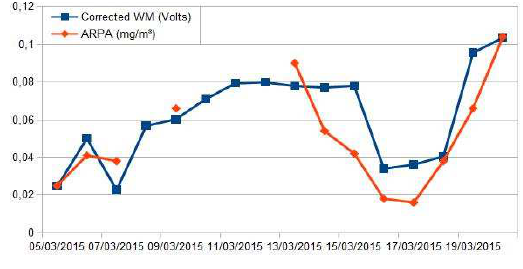
Figure 2. Calibration of the dust